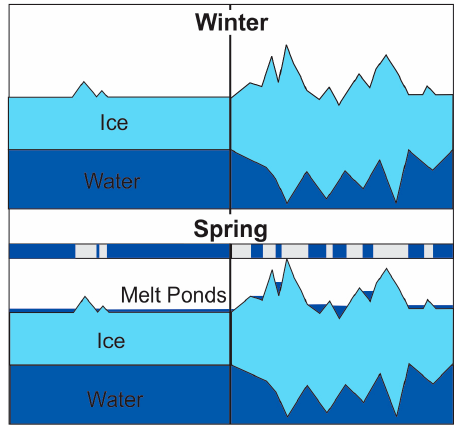
Figure 1. Schematic of our melt pond formation hypothesis derived primarily from in situ studies of sea ice evolution. Top panel shows a cross-section of pre-melt conditions of thin/smooth ( left ) and thick/rough ( right ) sea ice prior to melt. Bottom panel shows a cross-section during spring conditions. Left panel shows smooth/level ice dominated by extensive melt ponds. Right panel shows lower melt pond coverage due to high surface topography. Blue and grey bar in the center illustrates a bird’s-eye view of melt pond extent.